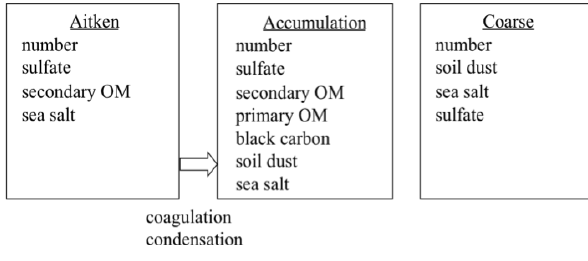
Fig. 2. Predicted species for interstitial and cloud-borne component of each aerosol mode in MAM3.